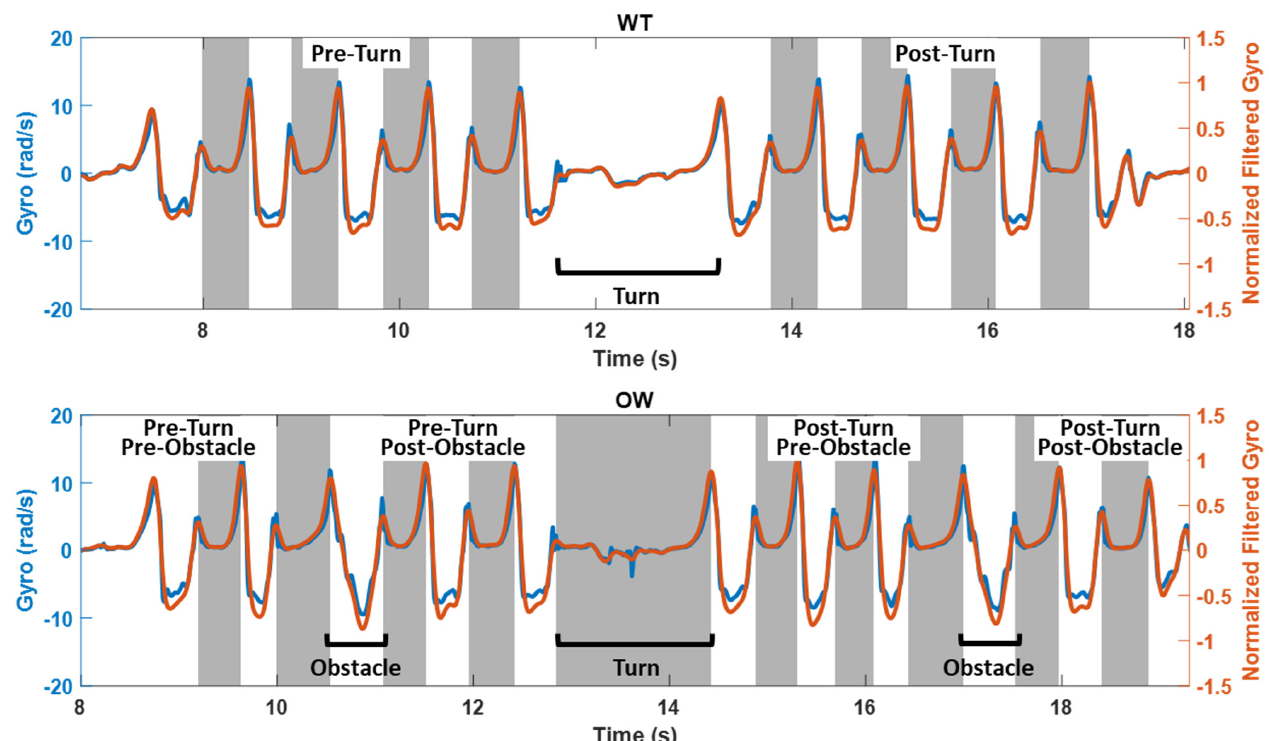
Figure 2. Example HS and TO detection from normalized filtered gyro from the right foot for the WT task (top) and the OW task (bottom). Raw mediolateral gyro data and normalized, filtered gyro data are in blue and orange, respectively. Gray shading marks HS to TO. Phases of the tasks, turning, and obstacle crossings are labeled. Note that detection of HS and TO were dependent on the expected peaks in the filtered and normalized mediolateral gyro signal.